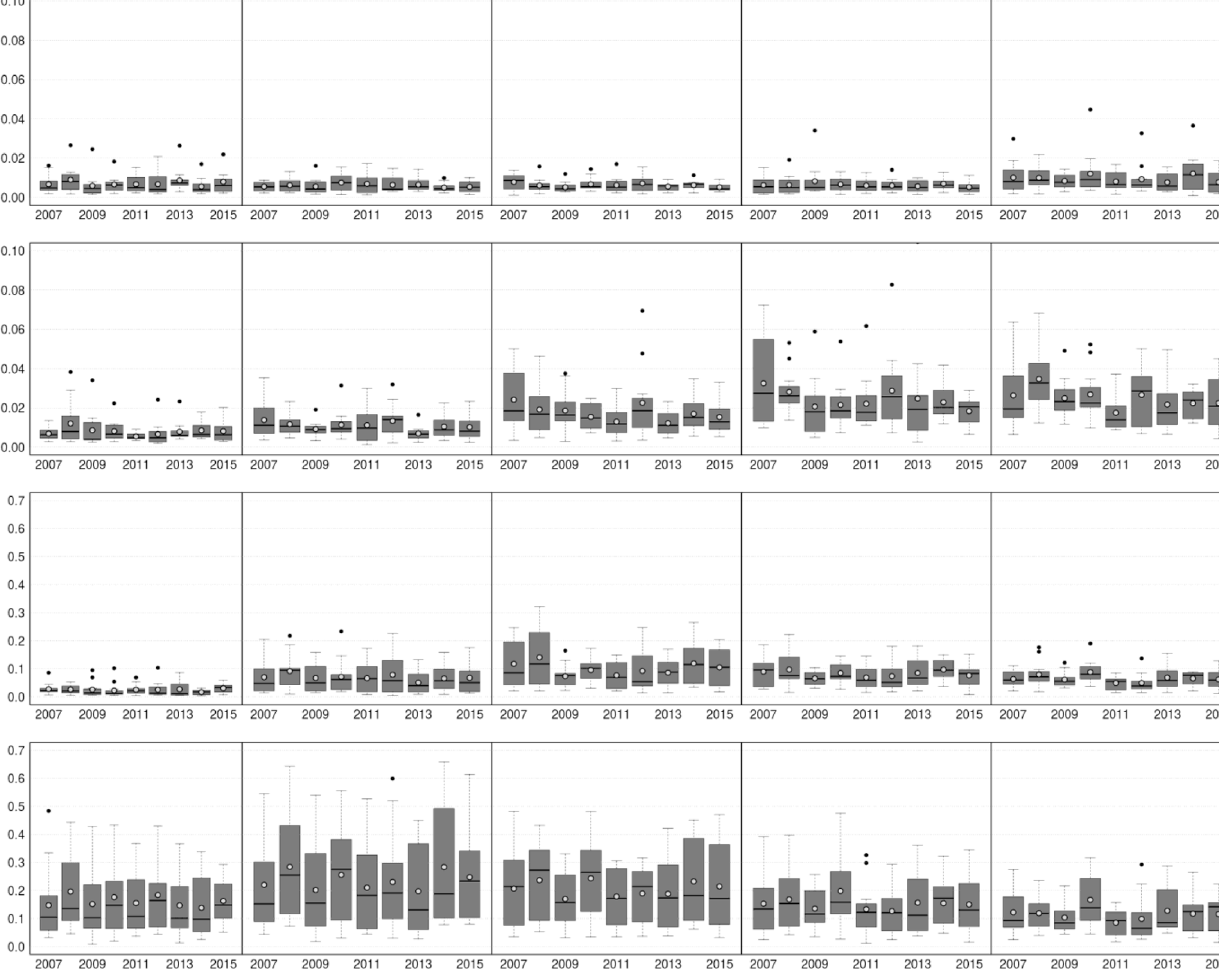
Figure 8. Interannual variability of the DODs for the 10 ◦ × 10 ◦ grid cells depicted in Fig. 7, for the period